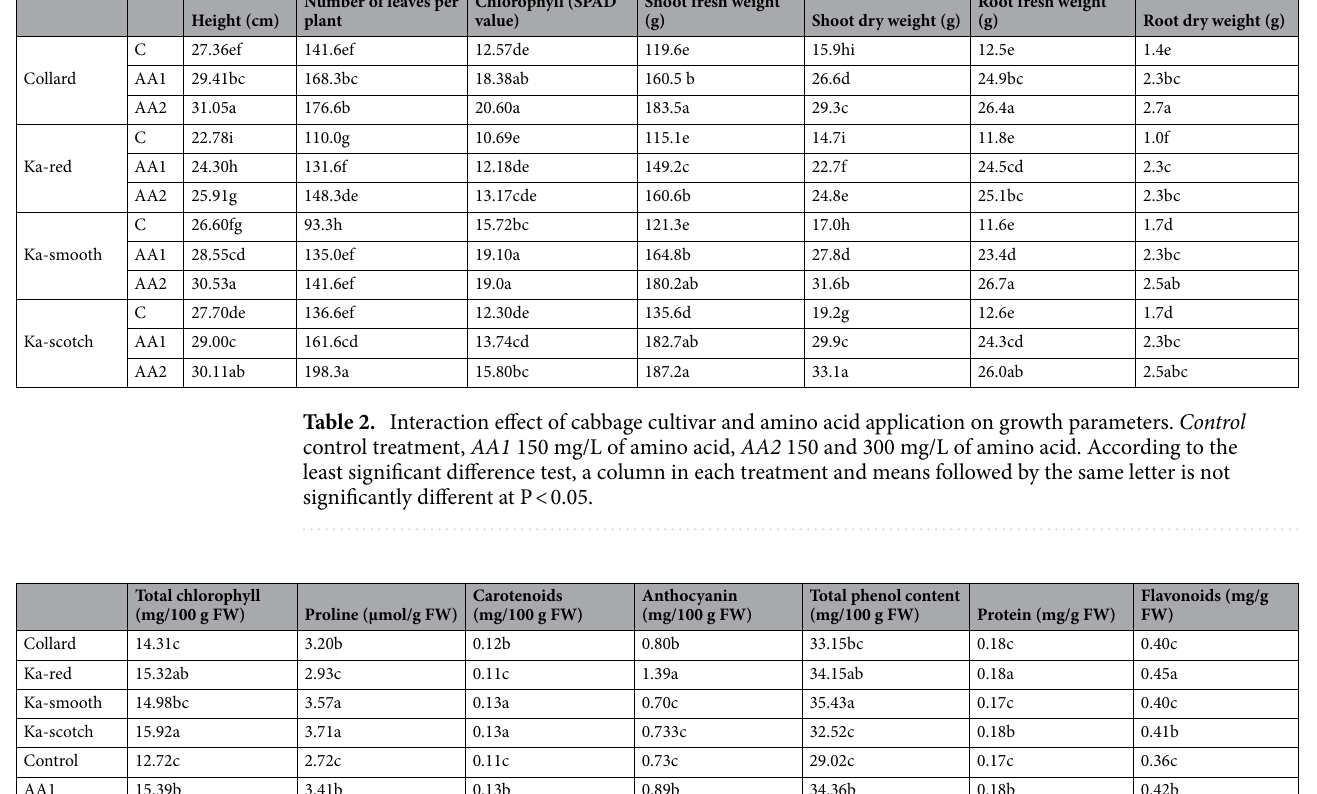
Table 3. The main effect of AA and cultivar on some biochemical characteristics of cabbages. Control control treatment, AA1 150 mg/L of amino acid, AA2 150 and 300 mg/L of amino acid. Within a column in each treatment means followed by the same letter are not significantly different at P < 0.05 according to the least significant difference test.